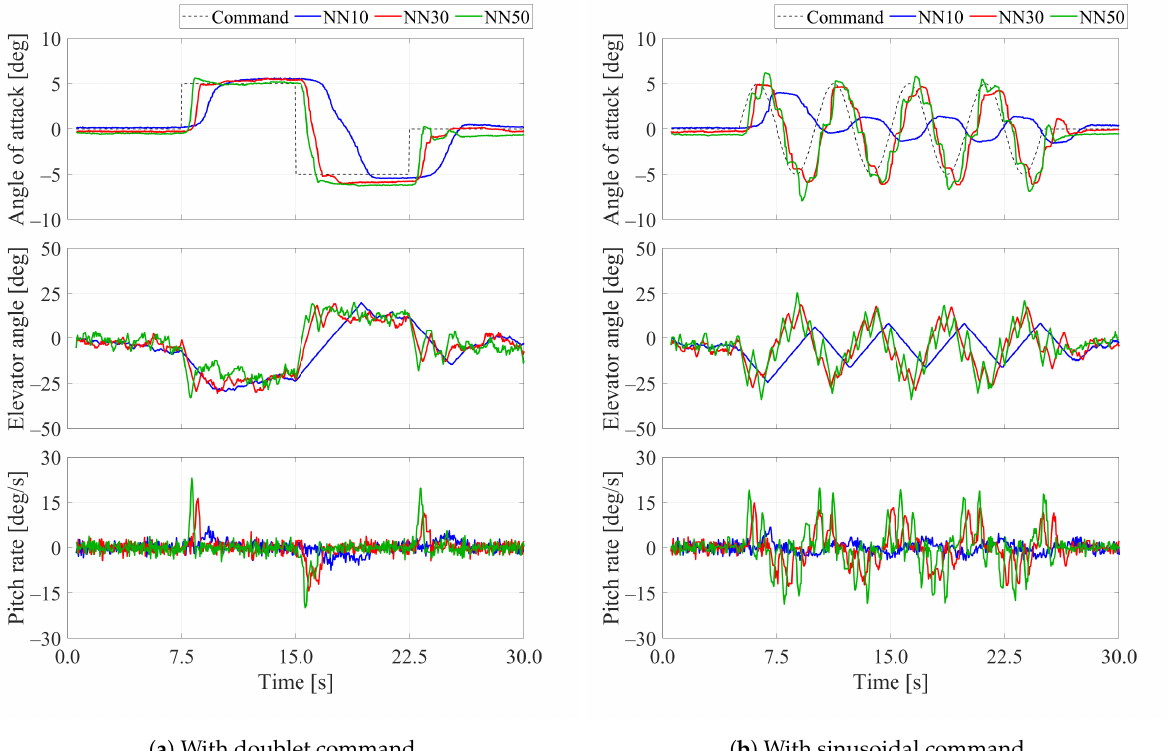
Figure 7. Pitch control results at wind speed of 14 m/s. NN10, NN30 and NN50 were used to follow doublet and sinusoidal